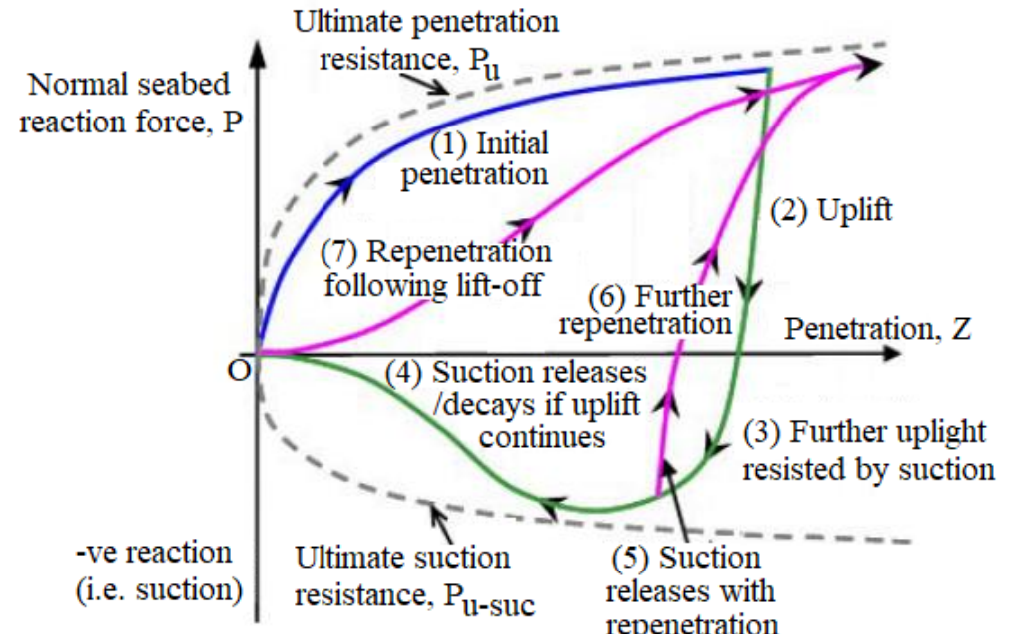
Figure 12. Soil model characteristics showing different modes (Adapted, courtesy of Orcina